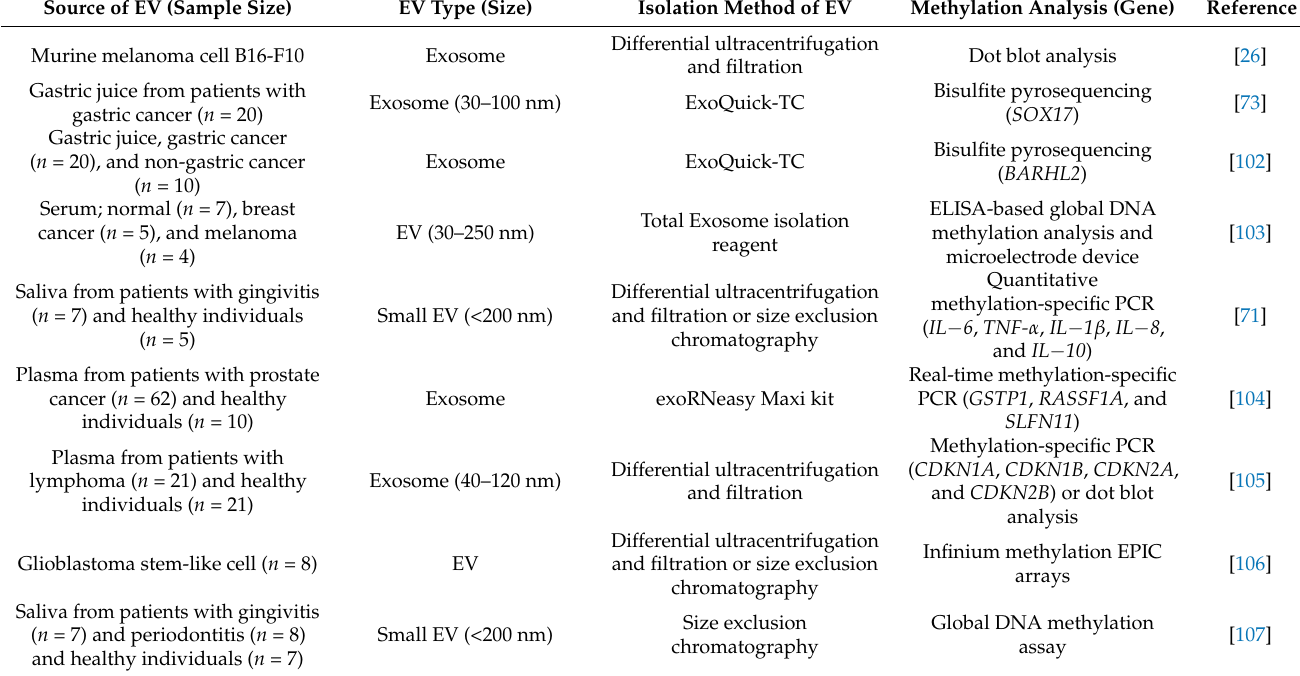
Table 1. Summary of methylation analysis performed with EV